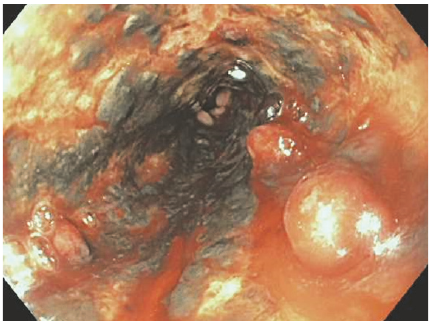
Figure 1: Middle esophagus showing discoloration, erythema, friability (with contact bleeding), granularity, hemorrhagic appear- ance, inflammation, nodularity, altered texture, and a decreased vascular pattern.